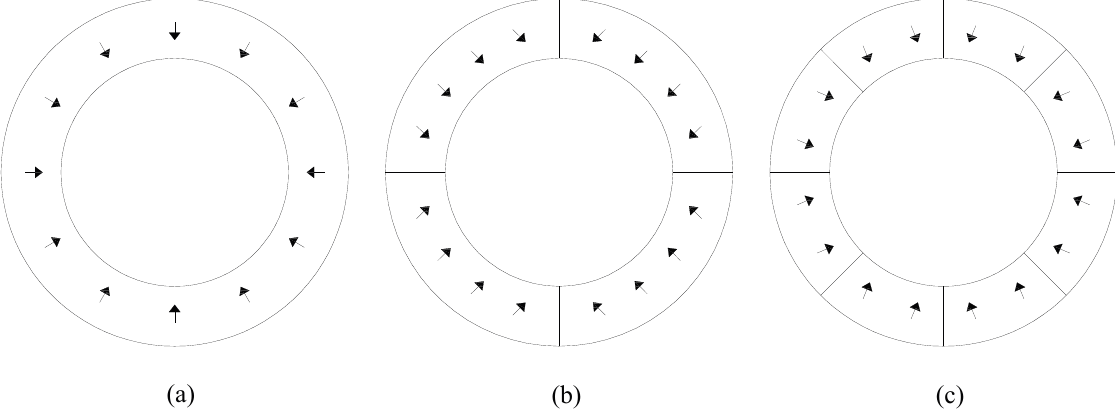
Figure 1. Permanent magnets with ( a ) ideal radial magnetization; ( b ) parallel magnetization with four segments forming a ring; and ( c ) parallel magnetization with eight segments forming a